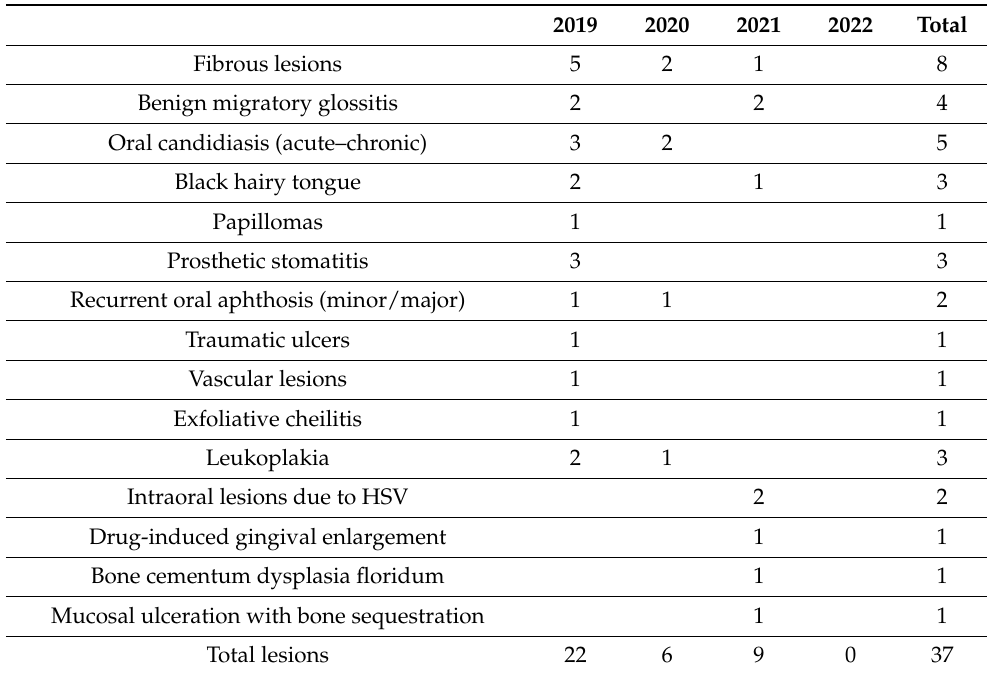
Table 3. Diagnosed oral mucosal